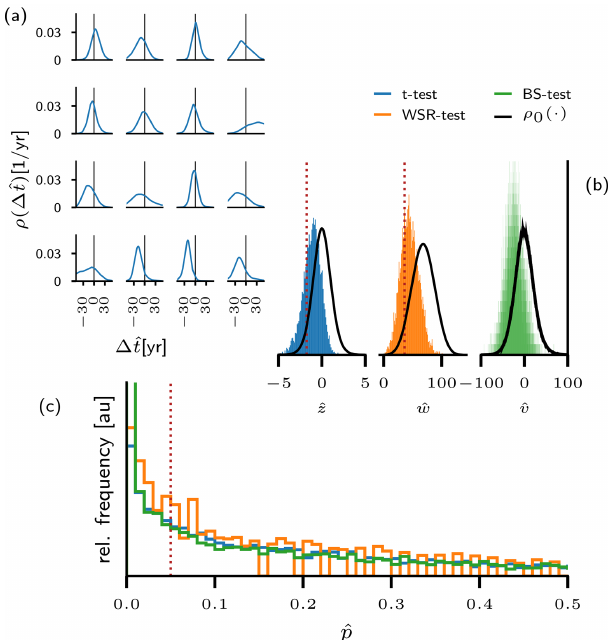
Figure 6. Exemplary application of the analysis to the proxy pair (Ca 2 + , Na + ) from the NGRIP ice core. Panel (a) shows 16 uncer- tain time lags (cid:49) ˆ T i derived from the proxy data around DO events. The continuous densities have been obtained via a Gaussian ker- nel density estimate from the corresponding MCMC samples (see Sect. 3.1). In panel (b) the uncertain test statistics induced by the uncertain sample are shown for the t test (blue), the WSR test (or- ange), and a bootstrap test (green). The values that comprise the his- tograms are immediately derived from the MCMC samples. Panel (c) shows the empirical uncertainty distribution for the p values of the three tests, following from the uncertain test statistics in panel (b) . Dotted red lines separate rejection from acceptance regions in panels (b) and (c) . In the case of the bootstrap test, the rejection re- gions cannot be defined consistently on the level of the test statistic, since each possible value (cid:49) ˆ t for the uncertain (cid:49) ˆ T generates its in- dividual null distribution. The null distribution shown here is in fact the pooled distribution of resampled ˜ v j obtained from all MCMC- sampled values for (cid:49) ˆ T . For the other proxy pairs investigated in this study, corresponding plots would appear structurally